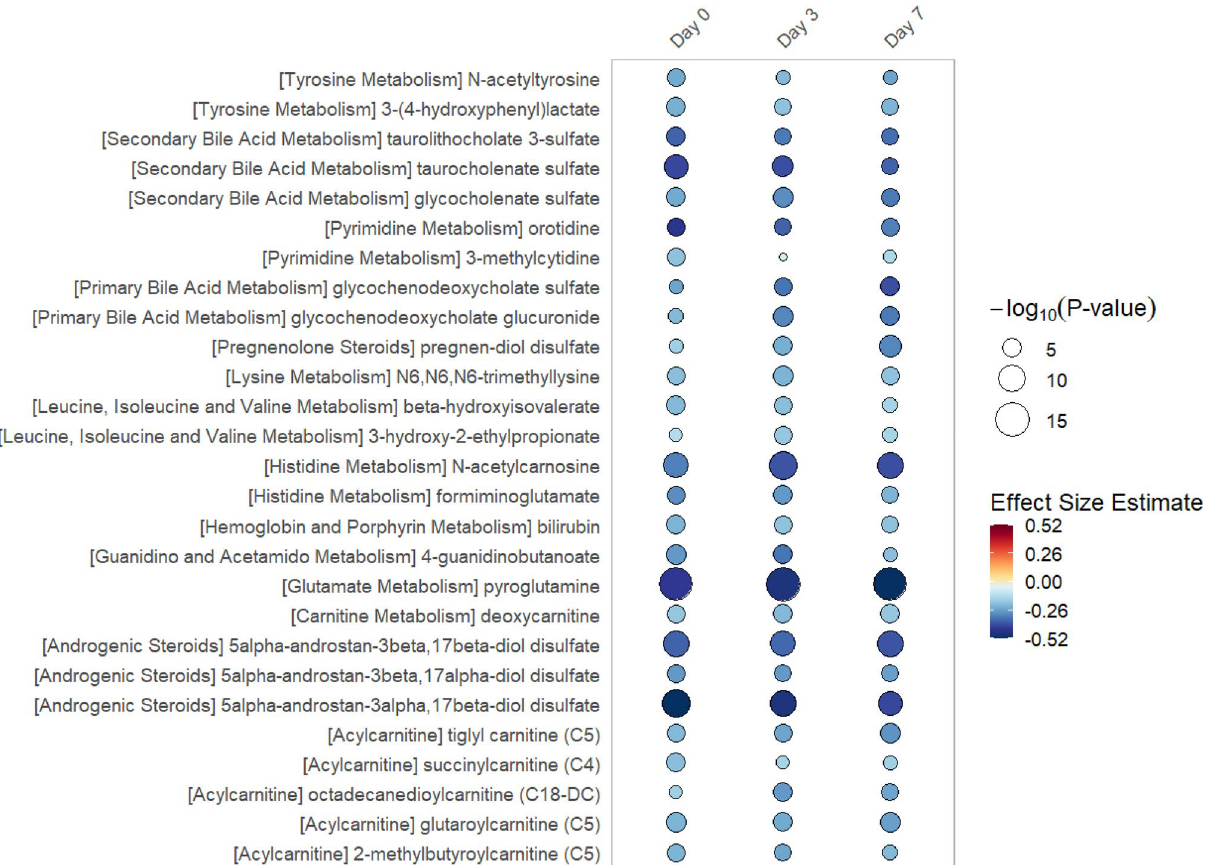
Figure 2. Rain Plot of single time point metabolites Decreased in Women. Correlations between individual metabolites and sex at day 0, 3 or 7 were determined utilizing linear regression models correcting for age, SAPS II, admission diagnosis, 25(OH)D at day 0. Day 3 and 7 estimates were also corrected for absolute change in 25(OH)D level at day 3. The magnitude of beta coefficient estimates (effect size) is shown by a color fill scale and the corresponding significance level (− log 10 ( P -value)) is represented by size of the circle. The blue fill color represents an decrease in effect size for that metabolite in women compared to men. Statistical significance is